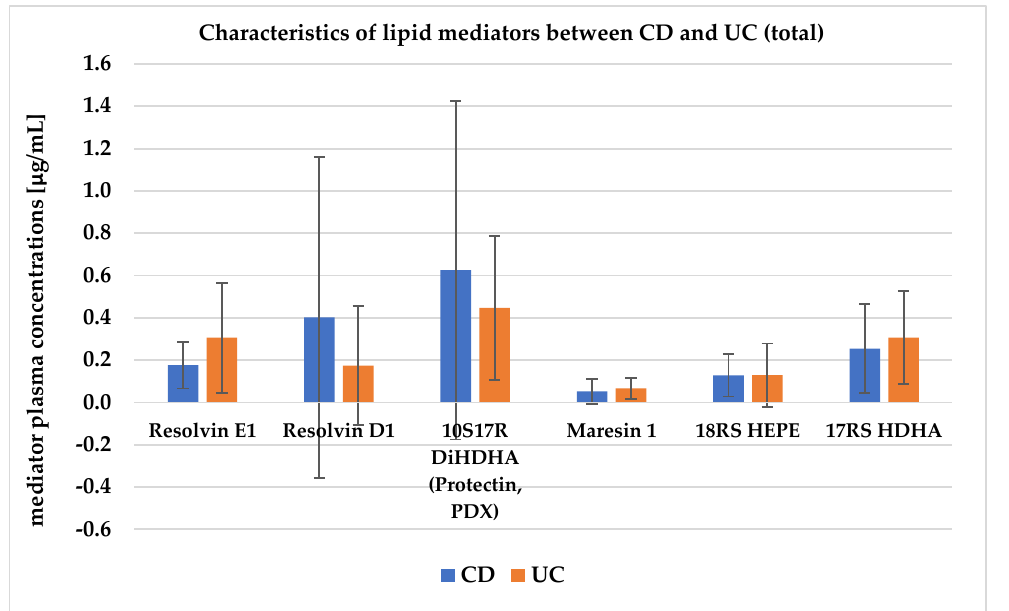
Figure 4. Characteristics of lipid mediators between CD and UC (total). CD —Crohn’s disease, UC — ulcerative colitis.